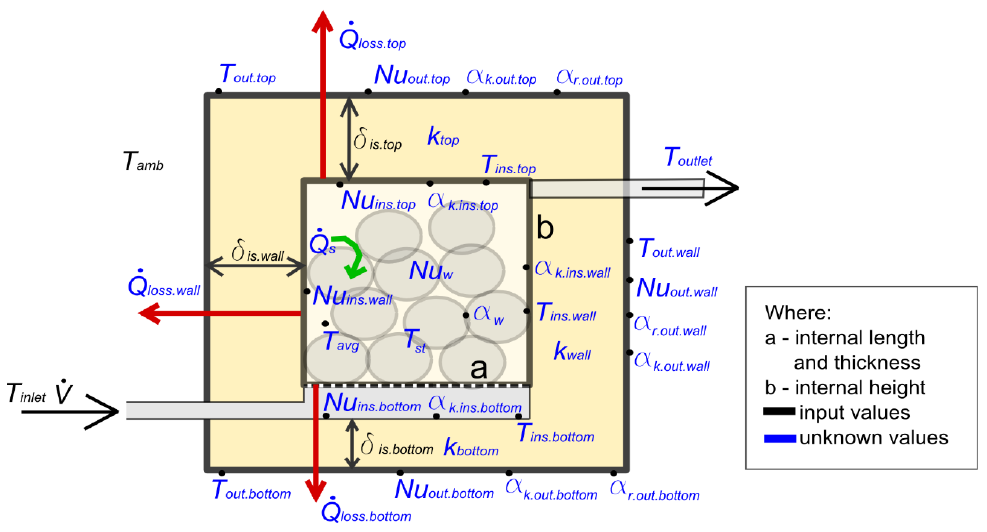
Figure 2. Scheme of the heat storage device with indicated input and calculation parameters.